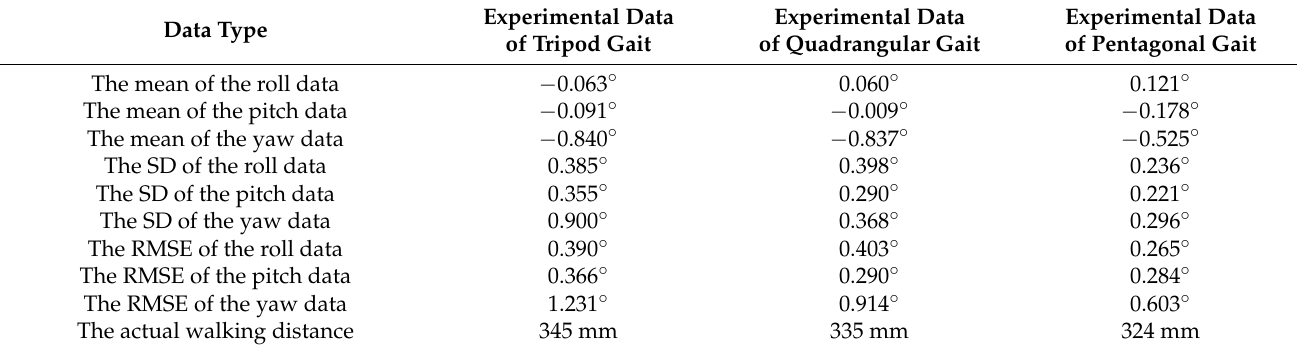
Table 5. Comparison of data in three